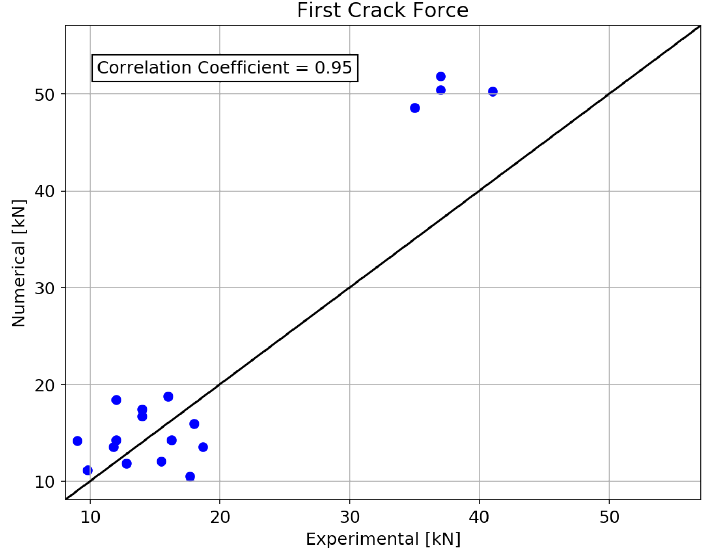
Figure 5. Comparison between numerical and experimental results regarding first-crack force.